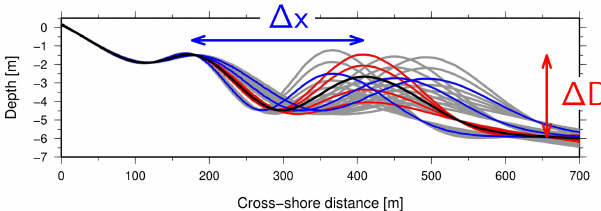
Figure 2. Geometry of cross-shore beach profiles used in this study. Different colours are used to highlight that some of the profiles were specifically designed to analyse the effect of variations in the dis- tance or in the relative depth between sandbar crests.